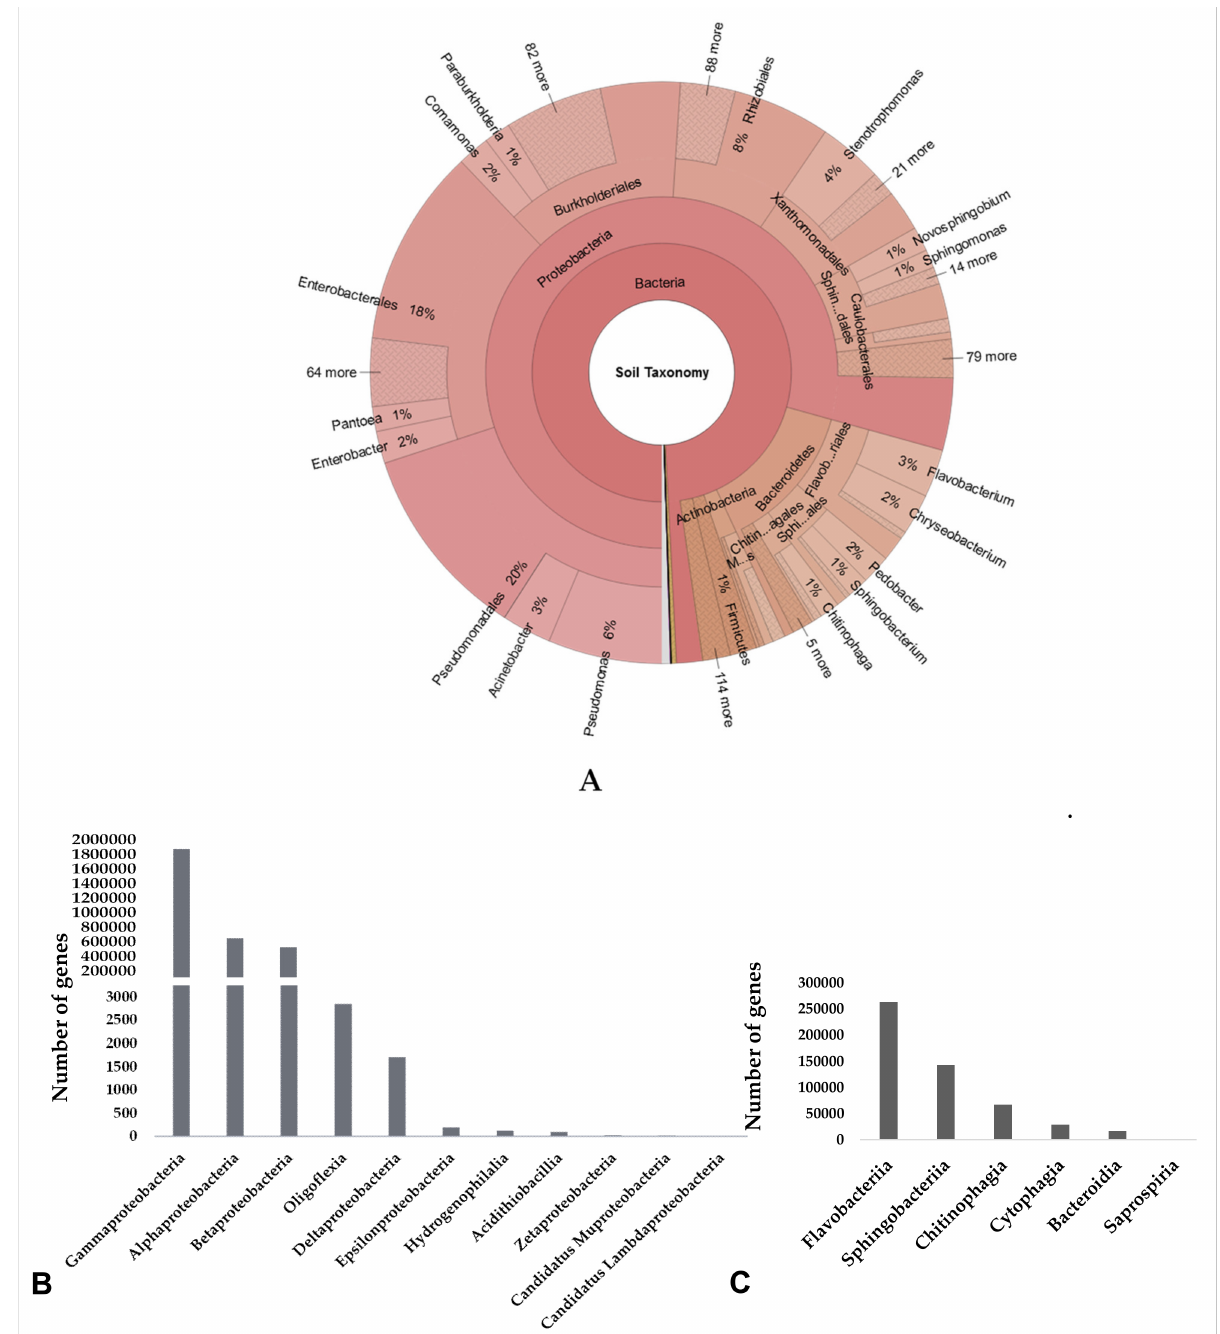
Figure 3. ( A ) Microbial community structure in humus samples surrounding white-rot fungi degrading deadwood in the Cuc Phuong forest at kingdom, phylum, order, and genus levels; ( B ) Proteobacteria composition at class levels; ( C ) Bacteroidetes composition at class